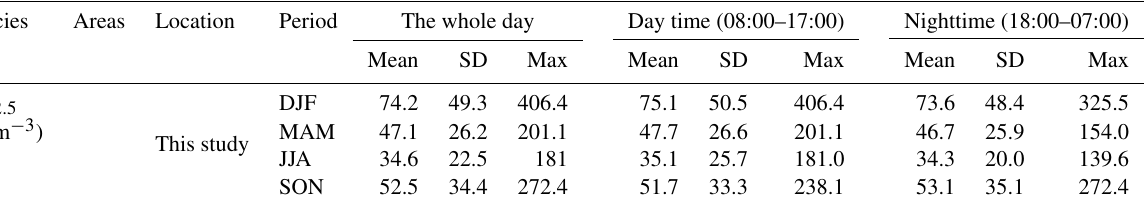
Table 2. Mean species levels for different seasons and different times of day and comparisons with other previous data reported in typical regions in China. SD represents standard